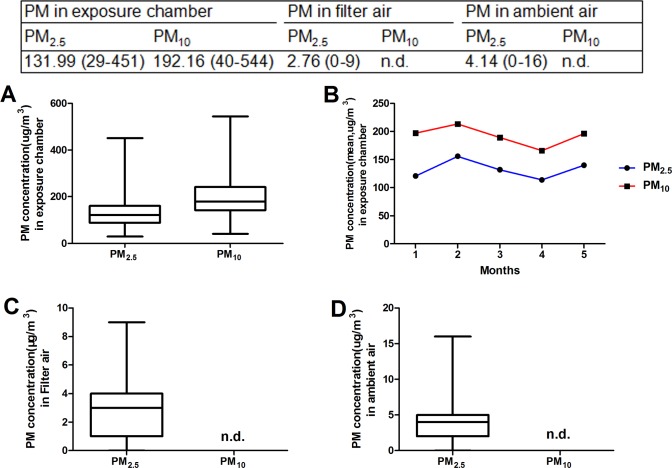
The concentration of PM2.5 and PM10 in different chambers (Median).(A) PM2.5 and PM10 in the exposure chamber. (B) The average concentration of PM in the exposure chamber. (C) PM2.5 and PM10 in the filter air. (D) PM2.5 and PM10 in the ambient air. n.d.: not detectable.